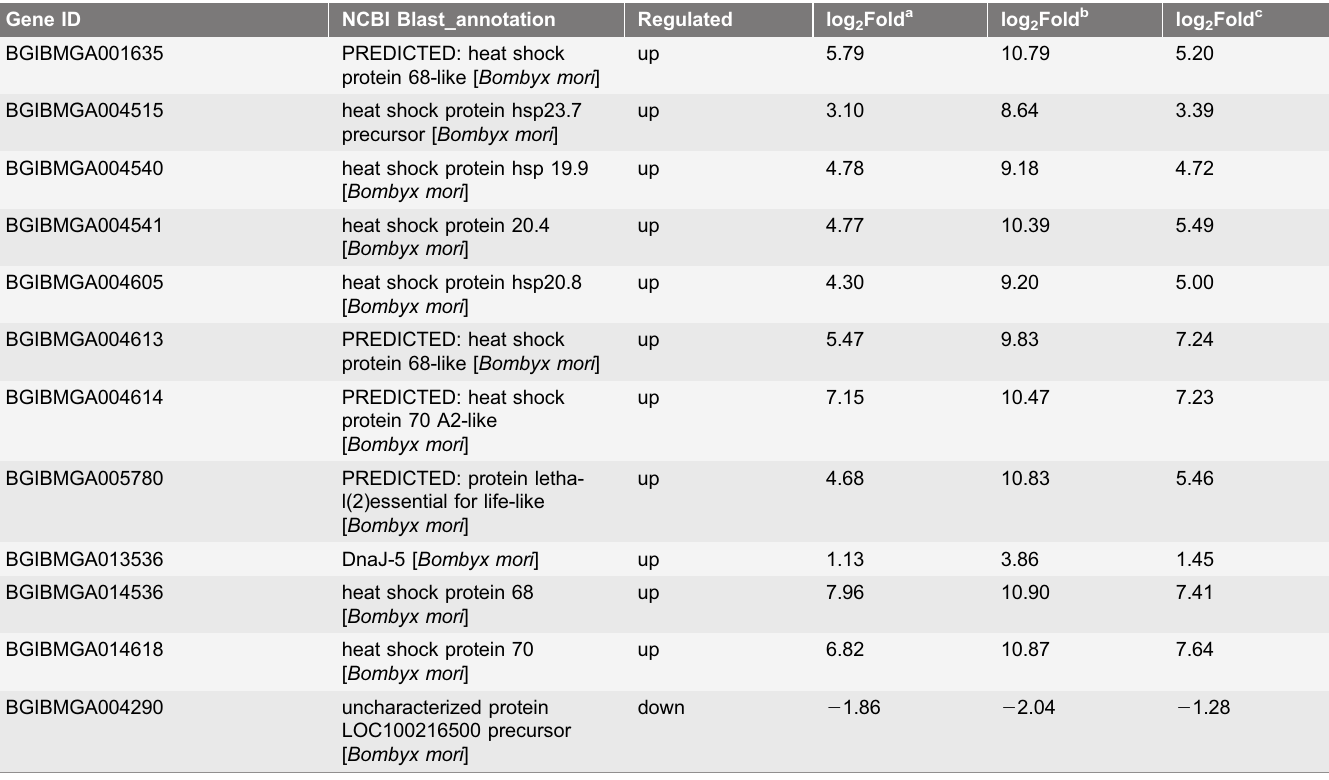
Note: Fold a indicates the ratio of RPKM of cot / cot ok / ok (42 ˚ C) sample divided by the RPKM of cot / cot ok / ok (25 ˚ C) samples; Fold b indicates the ratio of RPKM of + / + ok/ok (42 ˚ C) sample divided by the RPKM of + / + ok/ok (25 ˚ C) samples; Fold c indicates the ratio of RPKM of + / + + / + (42 ˚ C) sample divided by the RPKM of + / + + / + (25 ˚ C)